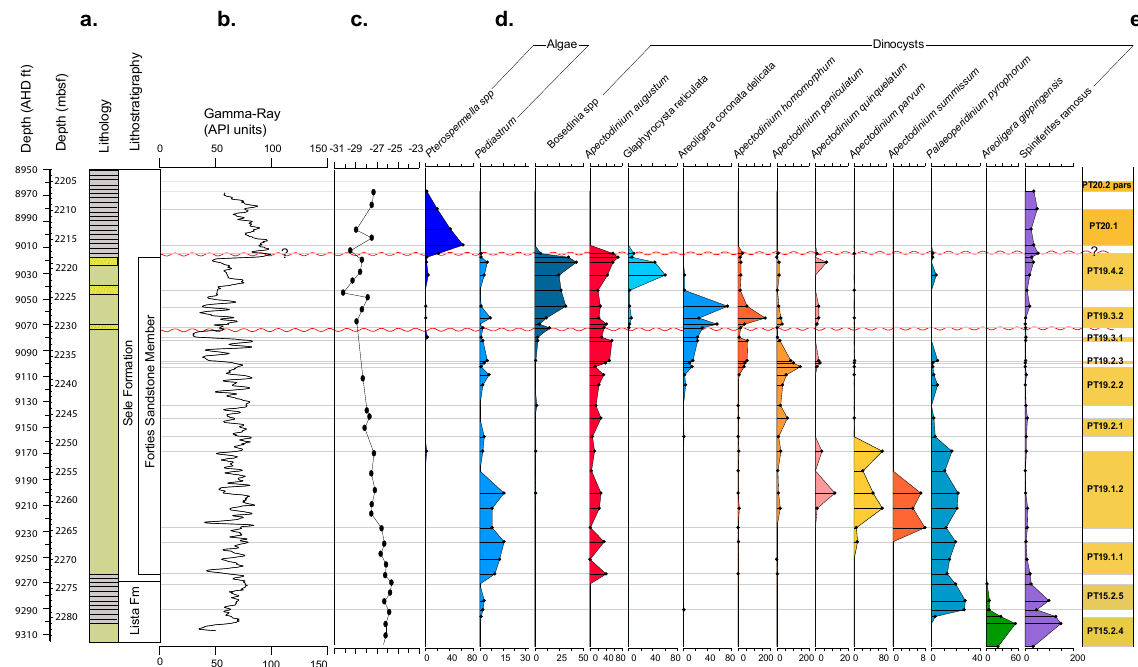
Fig. 2. Data from well 22/11-N1: (a) lithostratigraphy/lithology, (b) gamma-ray log, (c) carbon isotope data ( δ 13 C TOC ) , (d) selected distri- bution (specimen counts) of regional dinocyst bioevents, and (e) applied regional biostratigraphic zonation after Schroder